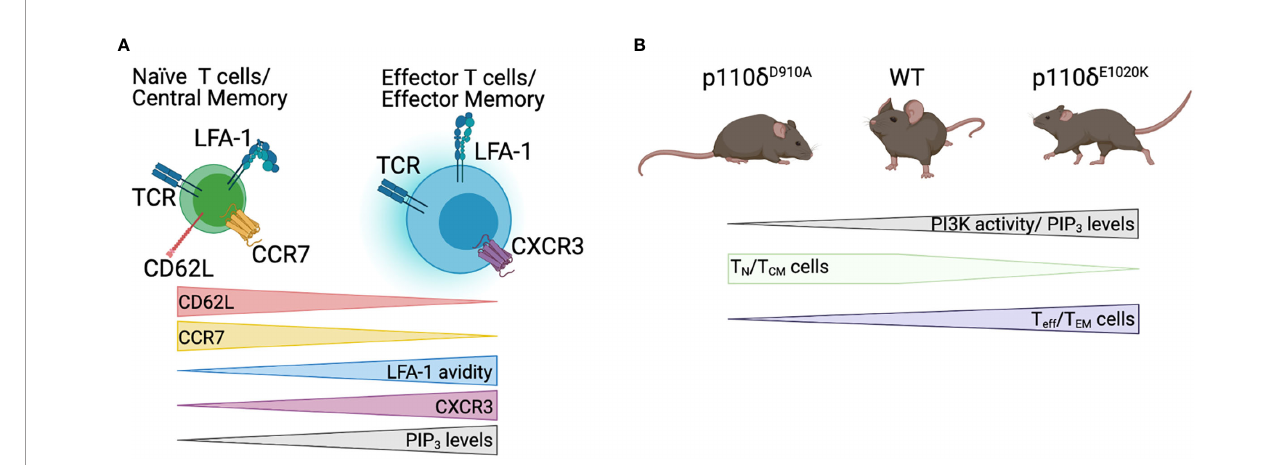
FIGURE 6 | Involvement of PI3K signalling in T cell migration. (A) Diagram of relative surface levels of CD62L, CCR7, CXCR3, and avidity of LFA-1 in naïve T cells (T N )/Central memory T cells (T CM ) and effector T cells (T eff )/effector memory T cells (T EM ). (B) Spectrum of PI3K activity in PI3K mutant mouse models, and how this affects the levels of T N / T CM and T eff /T EM cells. Figure made in